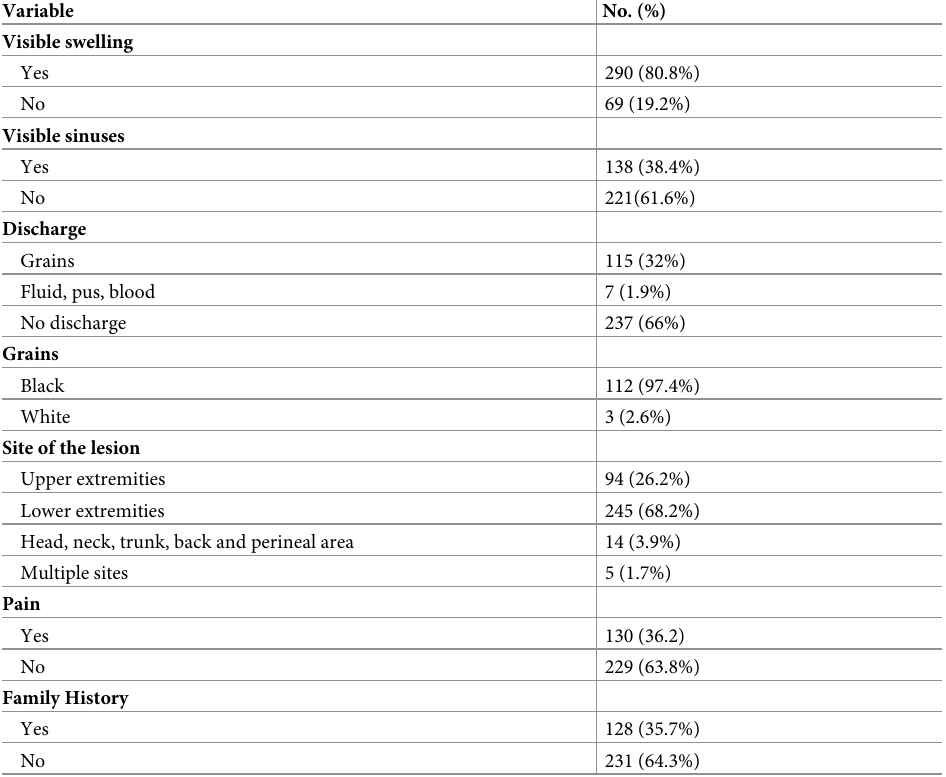
Table 1. The demographic features of mycetoma cases seen in Eastern Sennar Locality, Sennar State, Sudan. (N = 359 mycetoma cases and 41,176 surveyed individuals).